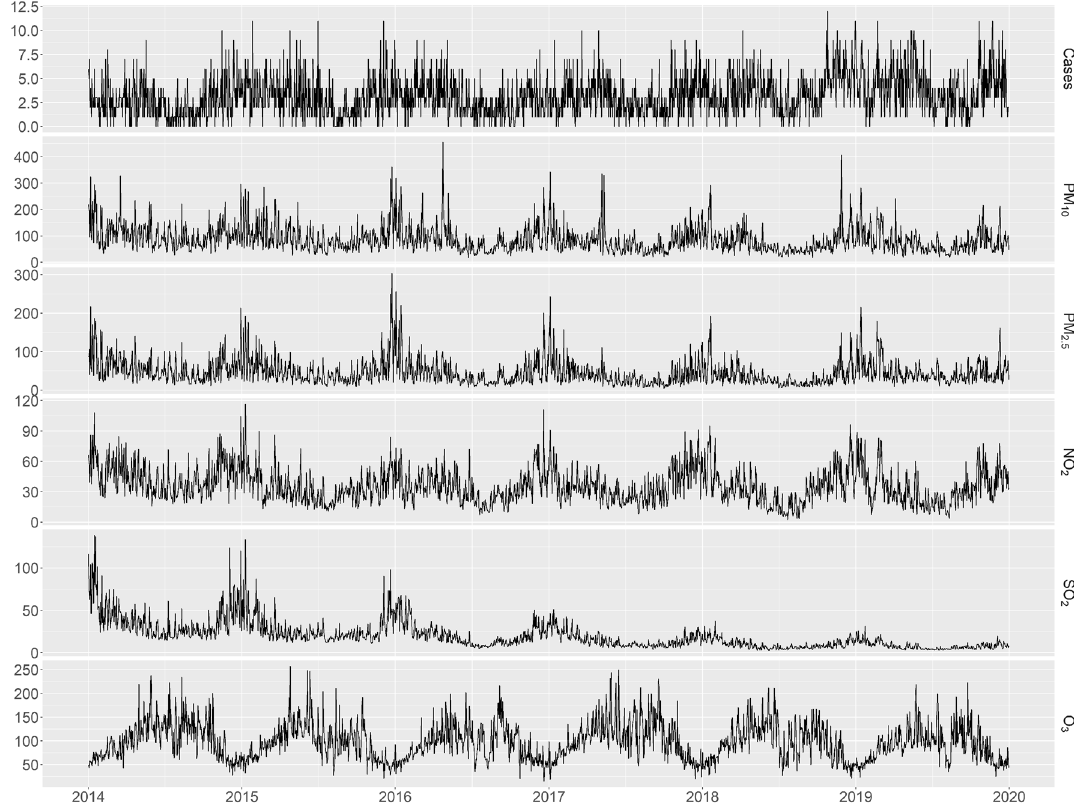
Figure 1. The temporal distributions of daily varicella cases and all air pollutants.